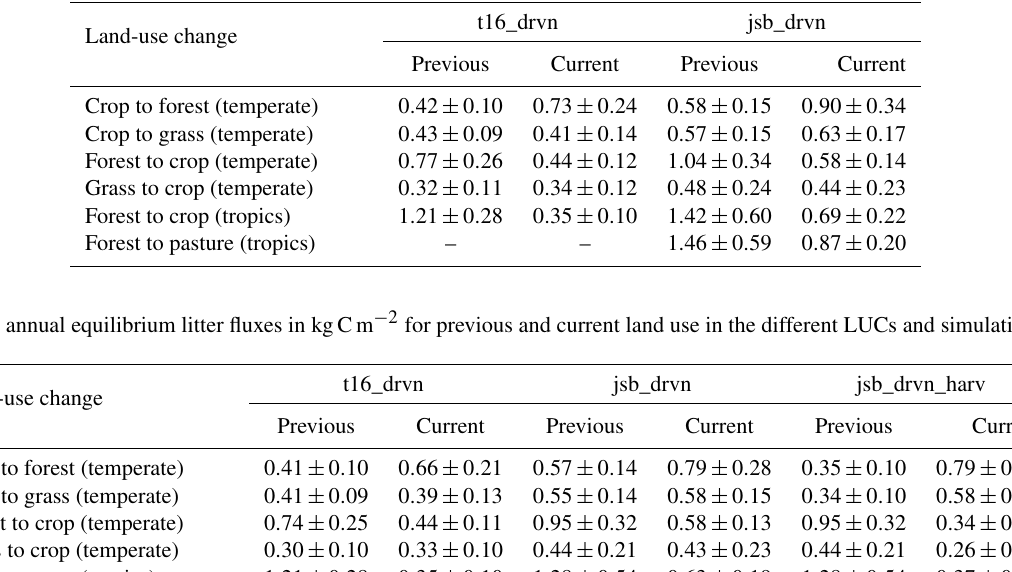
Table 4. Mean annual NPP for previous and current land use in kgCm − 2 for the different LUCs and simulations ( ± SD). Land-use change